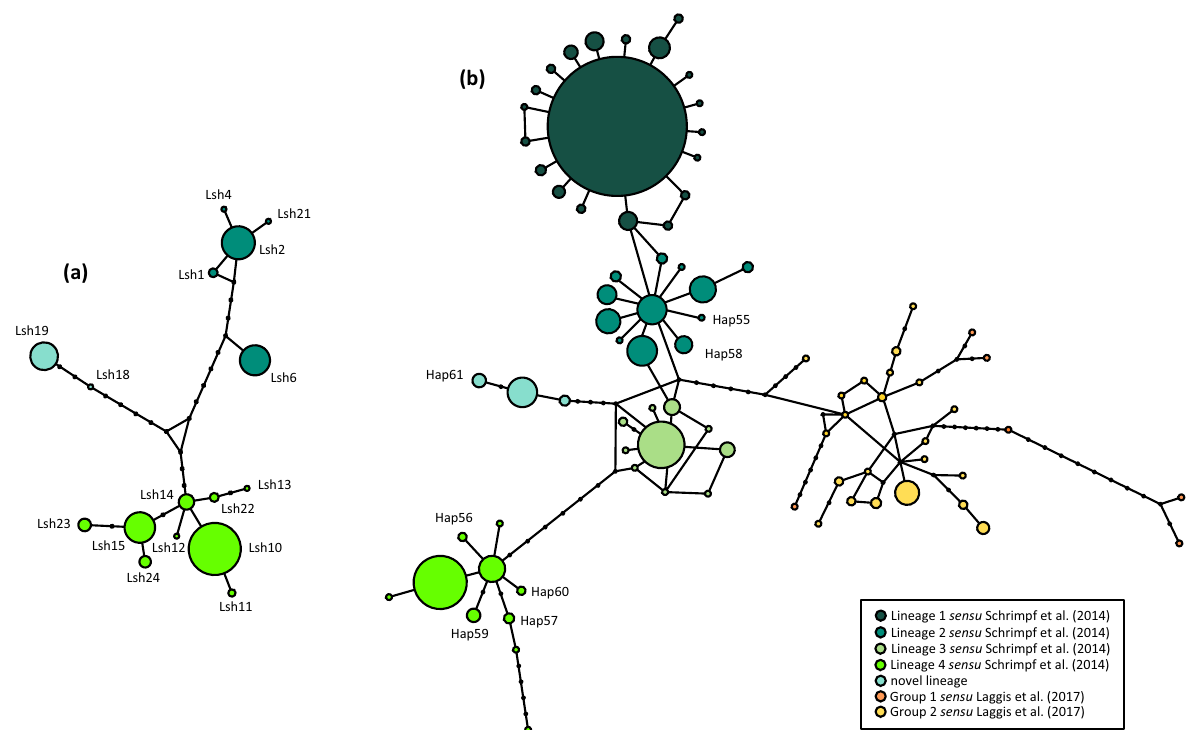
Figure 1. Median joining networks showing intraspecific phylogenetic relationships among (a) COI haplotypes from studied Croatian populations, and (b) concatenated COI + 16S haplotypes from a European-wide dataset of Astacus astacus, with novel haplotypes labelled. Colours depict samples affiliation to mitochondrial lineages sensu Schrimpf et al. 7 and groups sensu Laggis et al. 8